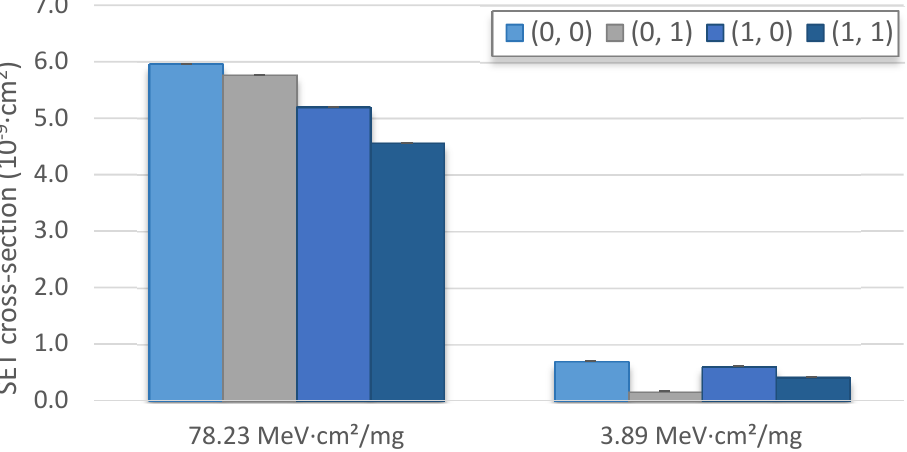
Figure 8. SET cross-section of each input combination of the 2-input NOR gate under 78.23 and Figure 8. SET cross ‐ section of each input combination of the 2 ‐ input NOR gate under 78.23 and 3.89 3.89 MeV · cm 2 / mg. MeV ∙ cm 2 /mg.